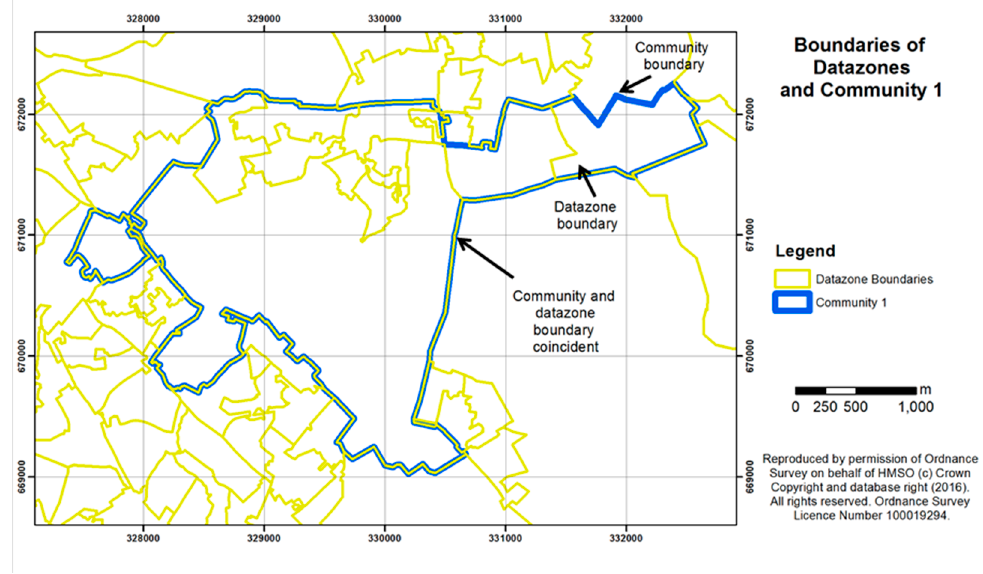
Figure 5. Community 1 outline showing boundaries of the datazones used for calculating the percentage area of green space per survey participant.